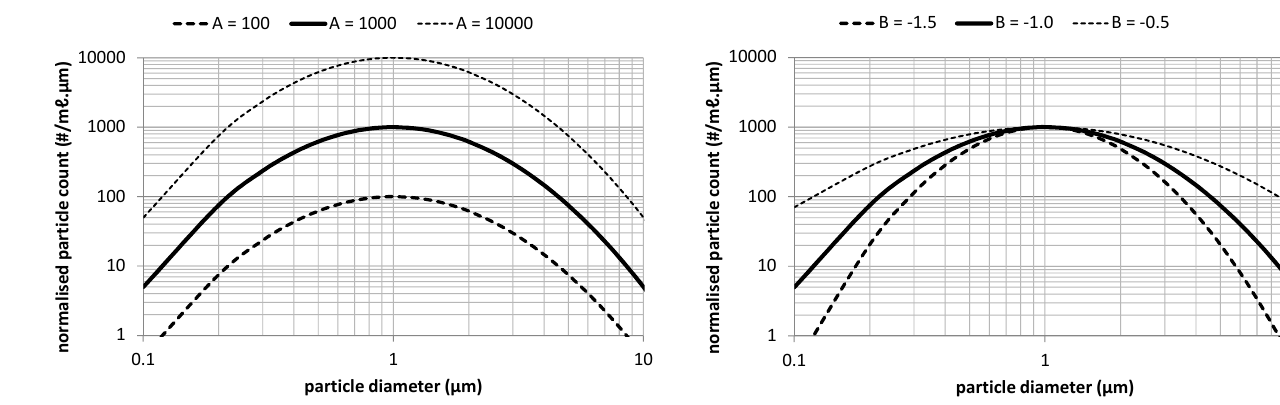
Figure 6. The e ff ect of model parameter β on the particle size dis- tribution, with A = 1000 and C = 0.